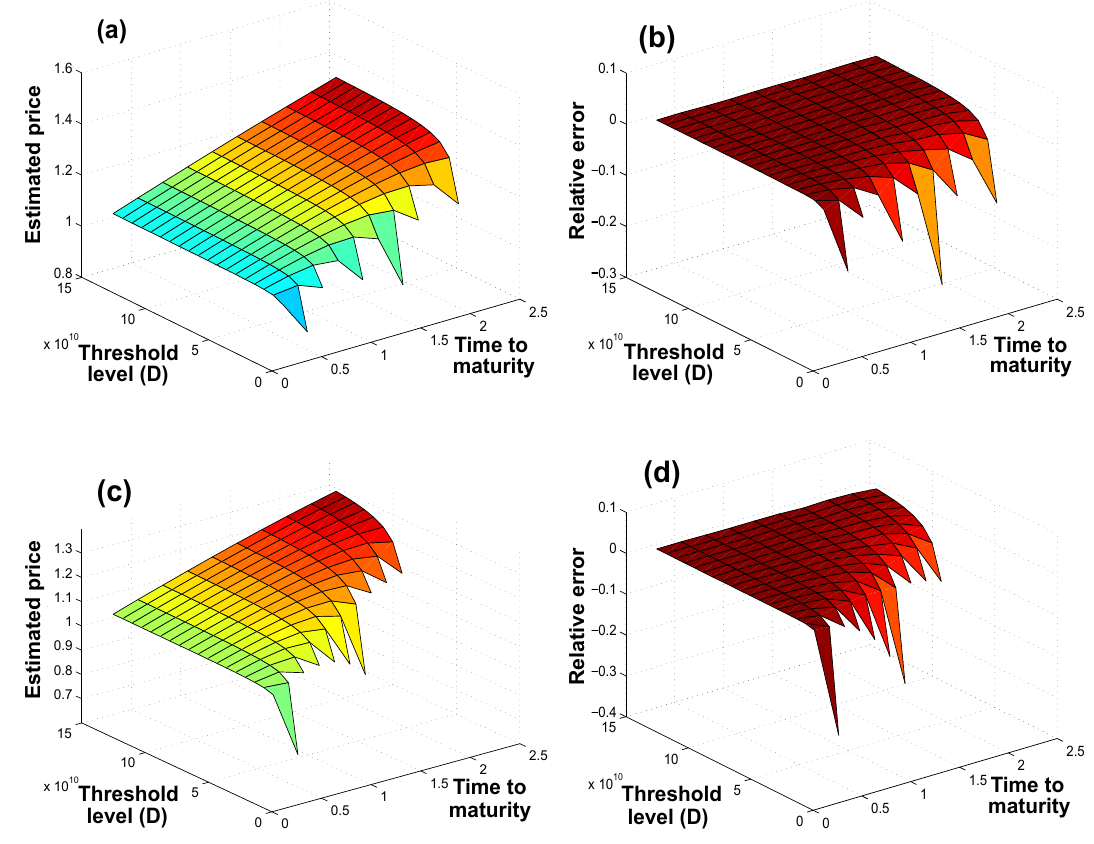
Figure A2. Pricing surfaces, obtained by using the stable weak approximations, for index-linked CP CAT bonds under the assumption of: ( a ) GP distributed losses (and the relative error to MC estimation in ( b )); and ( c ) Burr distributed losses (and the relative error to MC estimation in ( d )). Note the omission of points where the weak approximations were non-applicable, hence affording the figures their jagged